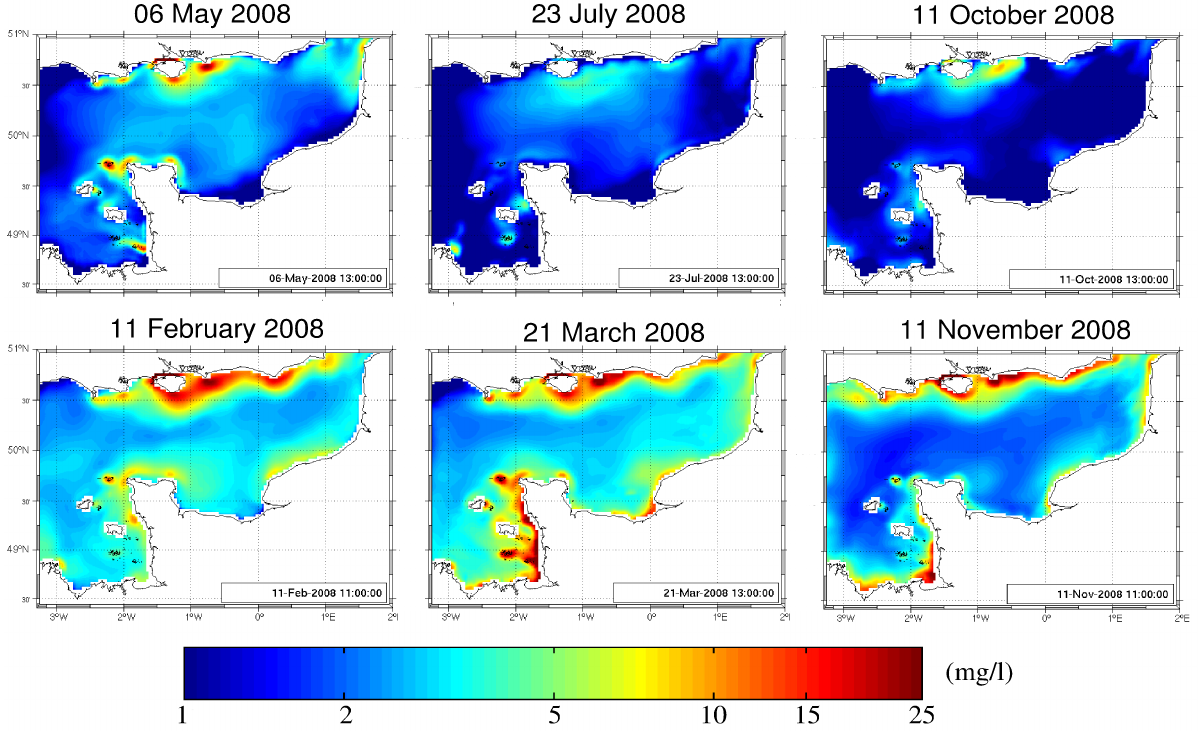
Figure 11. Near-surface SSC computed in Configuration E on 6 May, 23 July, 11 October, 11 February, 21 March and 11 November